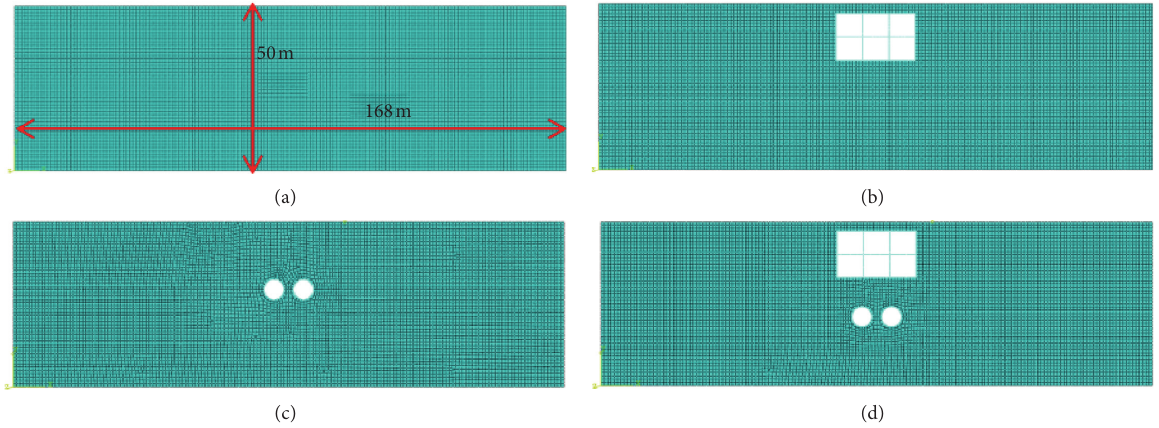
Figure 2: Finite element model. (a) Free-field model. (b) Soil-station model. (c) Soil-tunnel model. (d) Soil-tunnel-station